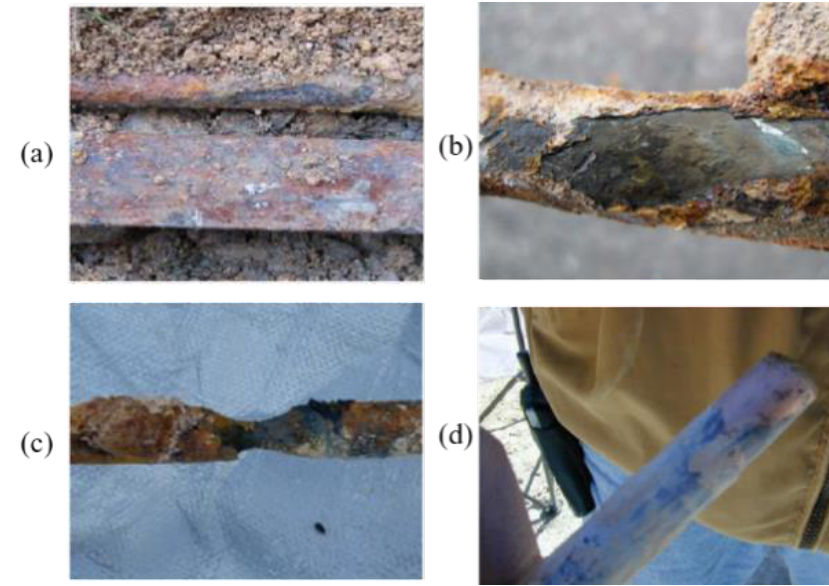
Figure 1. Corrosion of the grounding conductor: ( a ): excavation situation; ( b ): carbon steel; ( c ): galvanized steel; ( d ): copper-clad steel.